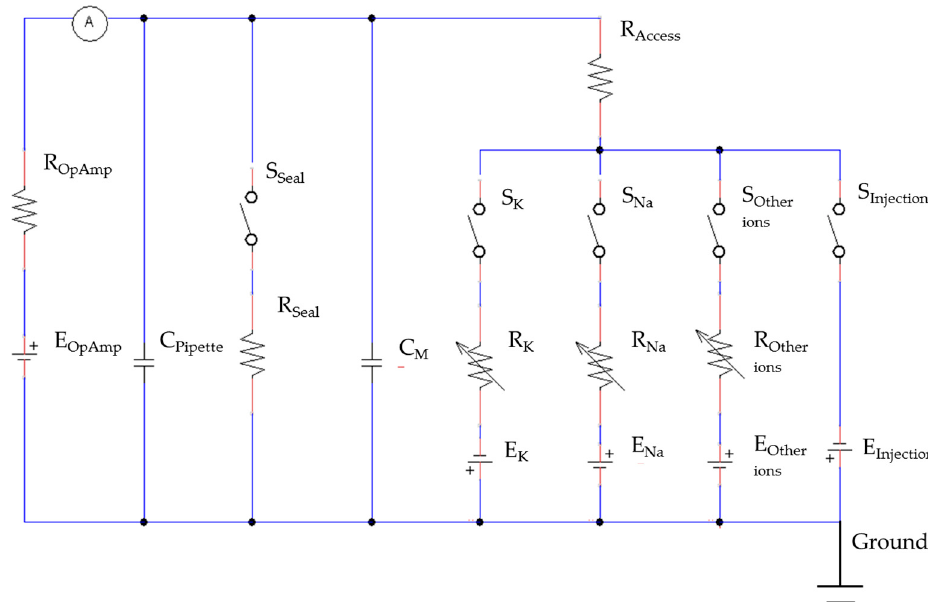
Figure 2. The equivalent circuit of the current feedback model for the cell cytoplasmic microinjection and cell viability verification.